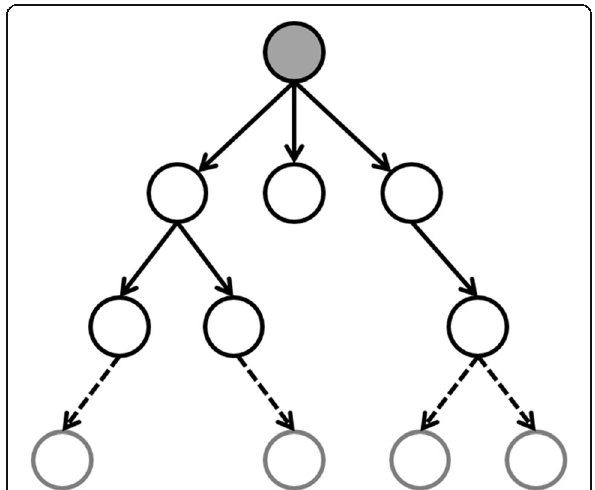
Fig. 1 Nodes in a WSN for time